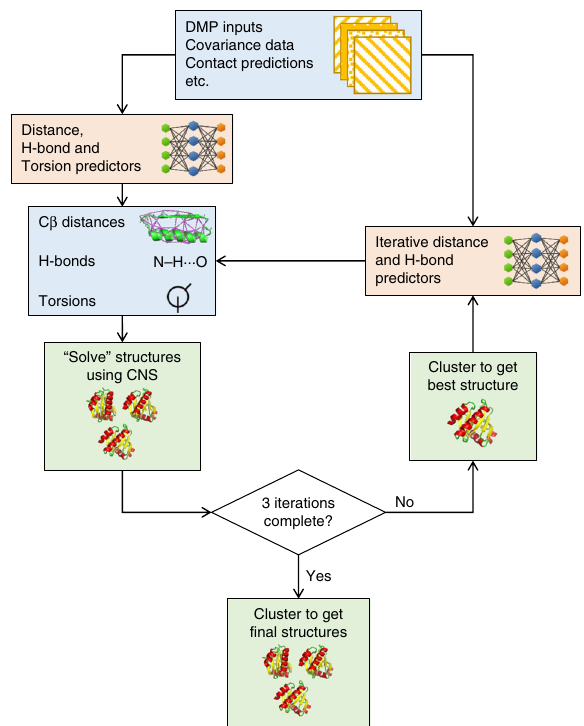
Fig. 8 Overview of the DMPfold pipeline. Initially inter-residue C β distances, H-bonds and torsion angles are predicted from DMP